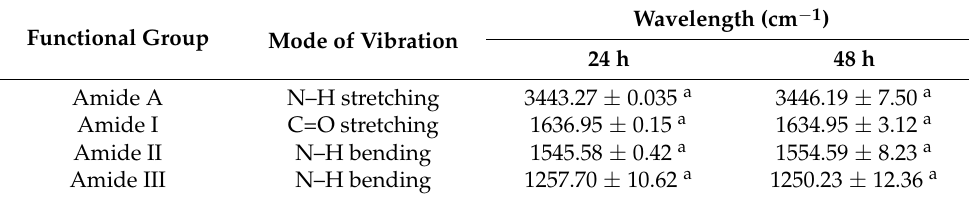
Table 3. Structural properties of extracted PSC at 24 and 48 h different extraction time.